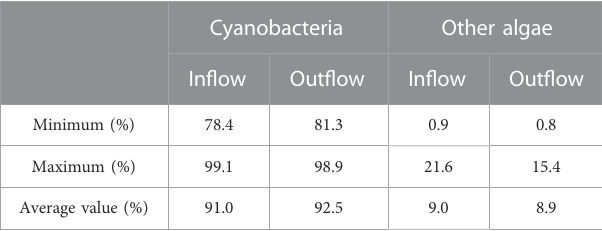
TABLE 2 Percentage composition of various species of phytoplankton in raw water.